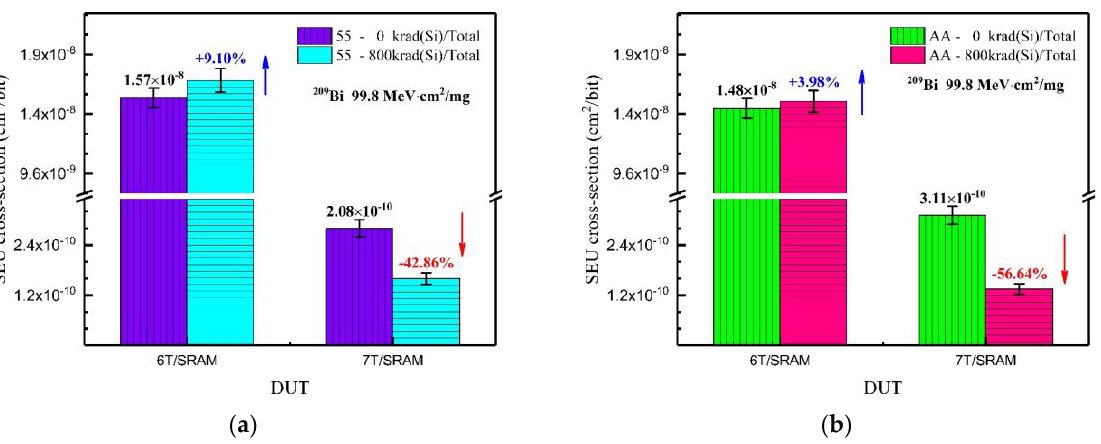
Figure 6. SEU cross-sections characterized by Bi ion versus layout structure for SOI SRAMs. The vertical column represents data for TID = 0 rad(Si), and the horizontal column represents data for TID = 800 krad(Si). The data pattern applied during SEU testing was ( a ) 55h and ( b ) AAh.